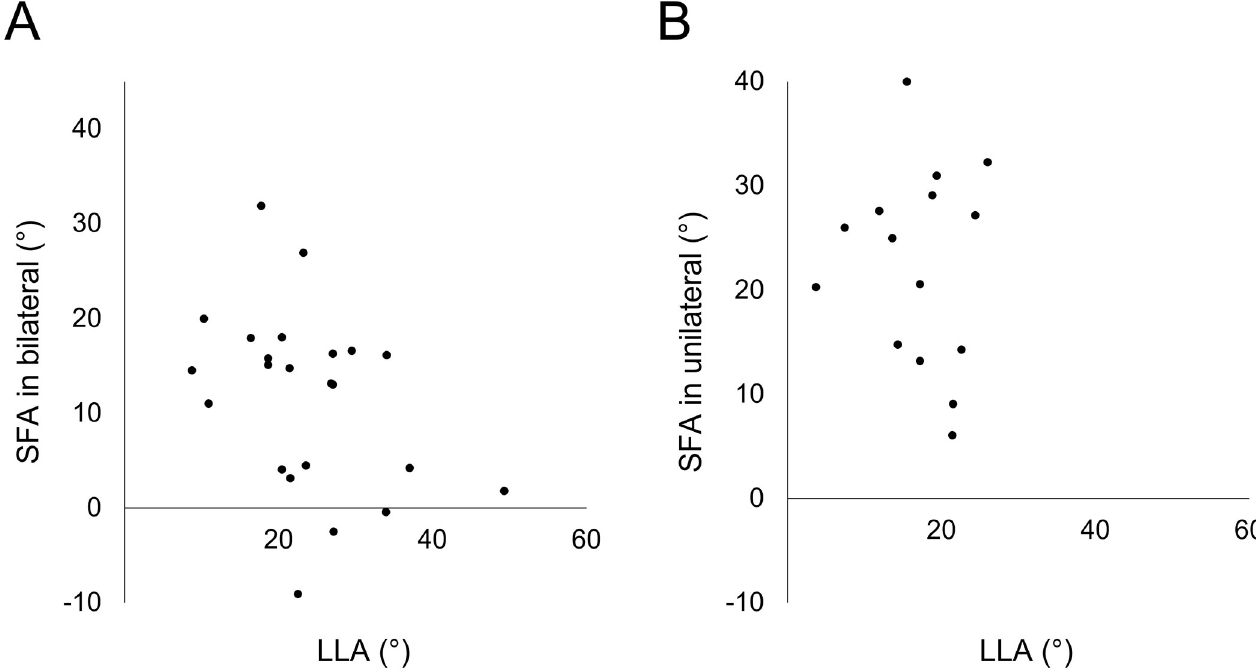
Fig 3. Scatter plot of spondylolysis fracture angle (SFA) and lumbar lordosis angle (LLA) in bilateral spondylolysis (A) and unilateral spondylolysis (B). There was no significant correlation between SFA and LLA [bilateral (p = .072), unilateral (p = .76)].